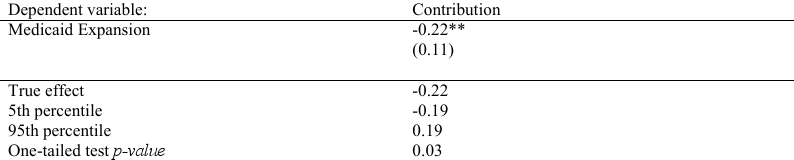
Figure 4: Permutation tests for the impact of Medicaid expansions on general nonprofit